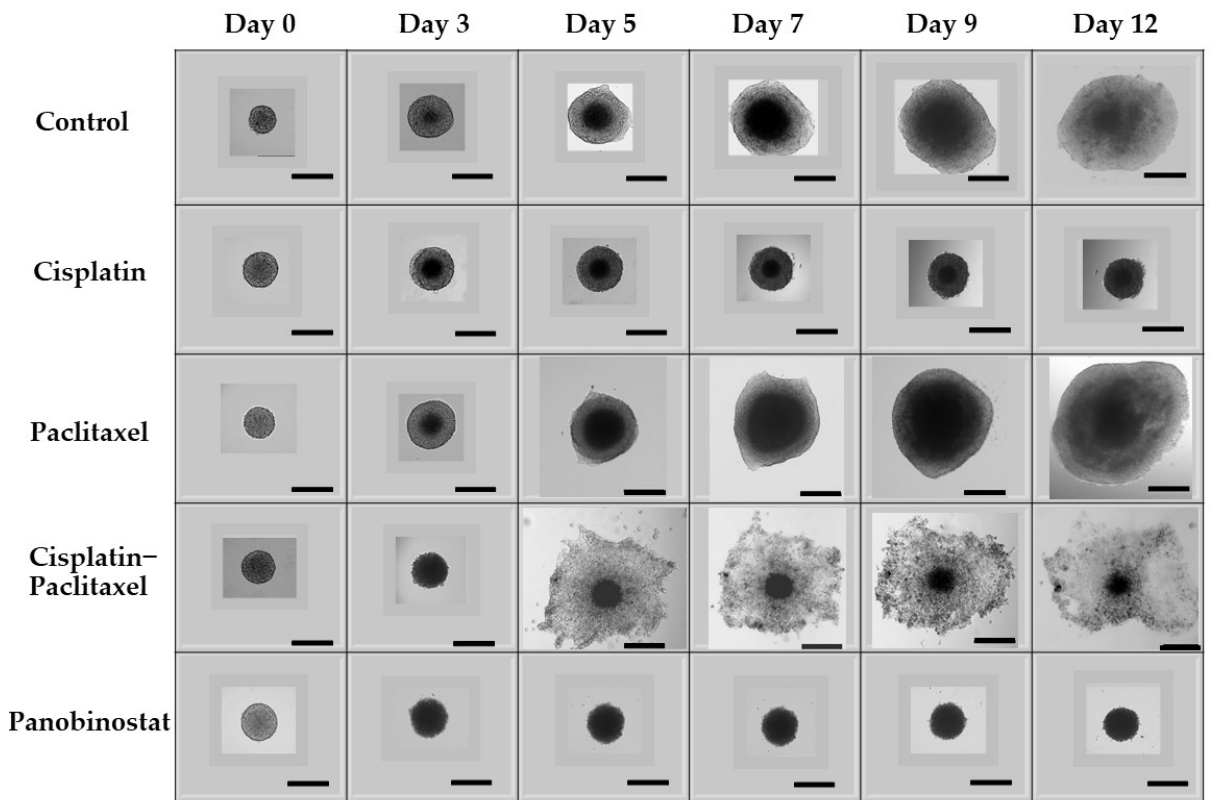
Figure 3. Direct visualization of 3D growth of Caov-3 cells under various treatments over time. In 3D culture, panobinostat is the only agent that causes Caov-3 spheroid shrinkage and decreases tumor spread. In contrast, in an extended kinetic, spheroids exposed to paclitaxel show extensive growth. Spheroids exposed to cisplatin and cisplatin–paclitaxel grew at a rate similar to the control. As seen in Appendix A, a similar trend was found with our Ovcar-3 spheroids. Scale bar is 500 µm ( n = 3).